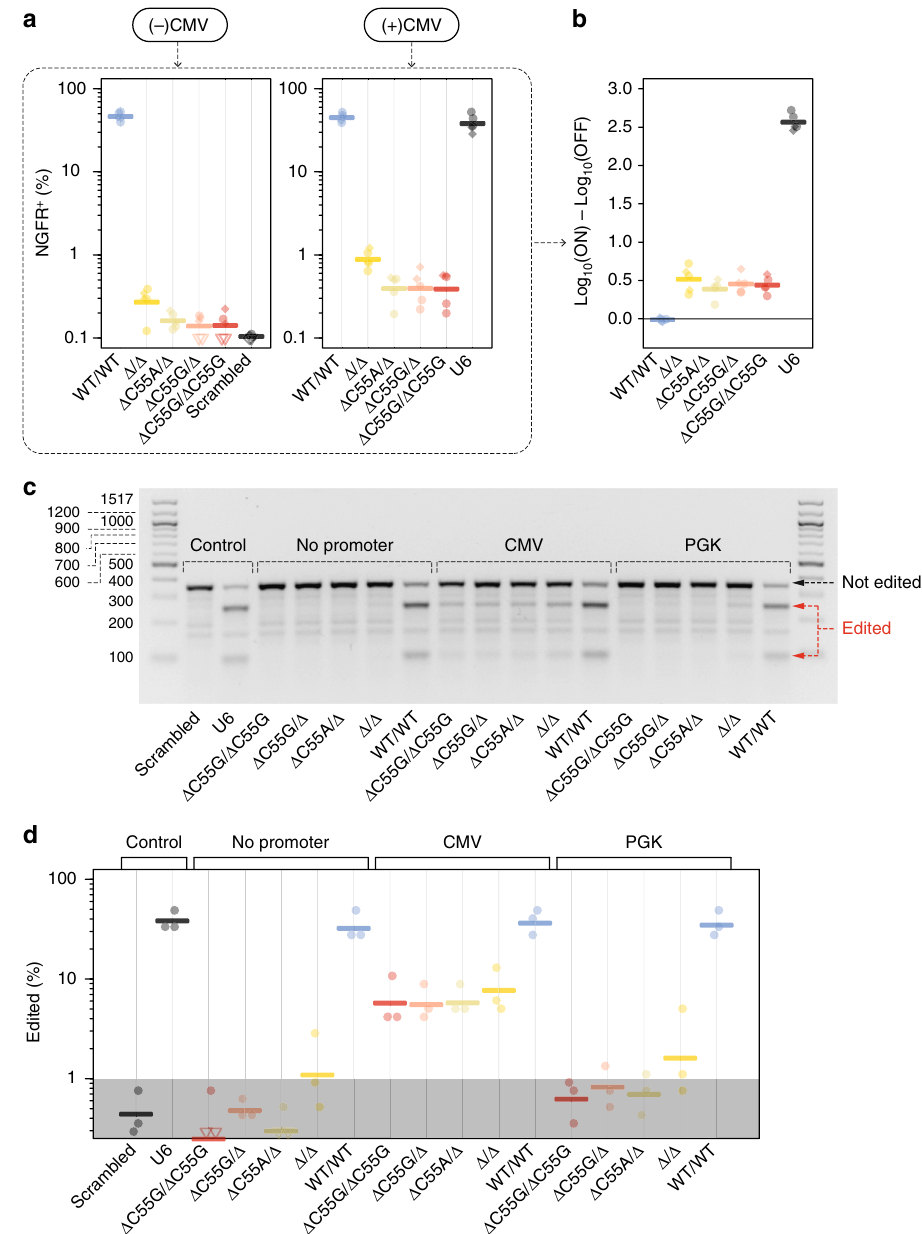
Fig. 4 Engineered tRNA Pro scaffolds enable Pol-II-speci fi c endogenous gene targeting. a Percentage of NGFR + cells within transfected cells for the OFF state (( − ) CMV promoter) and the ON-state (( + ) CMV promoter). Thick lines denote geometric mean values ( n = 5 independent experiments; diamonds = day 4 with antibiotic selection; circles = day 3 no antibiotic selection; see Methods). Points at or below limit of detection are displayed as hollow triangles or diamonds for antibiotic selected experiments. Threshold of detection was set as containing ~0.1% of events in the scrambled gRNA control. b Log 10 (% NGFR + cells) in the ON condition (( + ) CMV promoter) compared to OFF condition (( − ) CMV promoter). c Representative T7 endonuclease assay gel. tRNA scaffolds are shown beneath each plot with the 5 ′ variant/3 ′ variant indicated. A U6 promoter with a scrambled gRNA or with the targeting gRNA are included in as controls. Pol-II promoters for each set are noted above their respective lanes. Size in base pairs (bp) are shown next to the left side ladder. Black arrow = the location of uncut (not edited) amplicons; red arrows = digested (edited) amplicons. d Quanti fi cation of editing events from theT7 endonuclease gels. Thick lines represent geometric mean values ( n = 3 independent experiments). Shaded area represents the 75% credible mass for the scrambled gRNA control (see also Supplementary Figure 7). Source data are provided as a Source Data fi